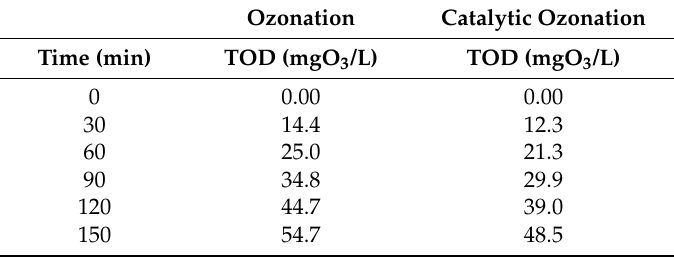
Table 1. TOD value through each treatment (single and catalytic